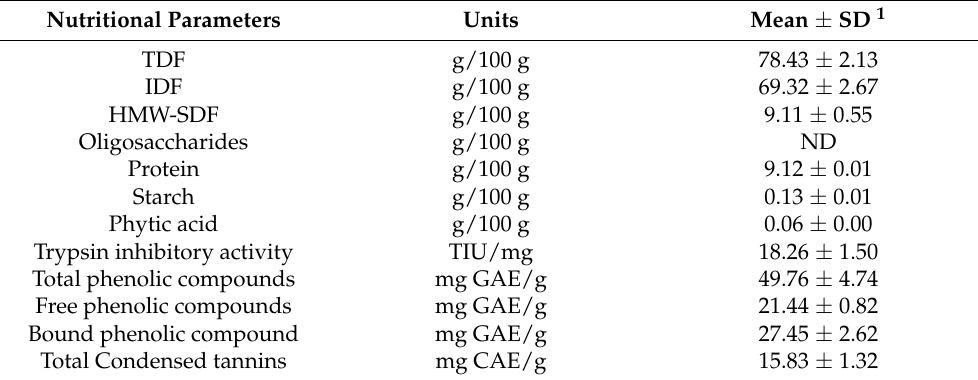
Table 1. Nutritional composition and total phenolic content of red lentil hulls from lentil processing industry (Prairie Pulse Inc., Vanscoy, SK, Canada). Nutritional Parameters Units Mean ± SD 1 TDF g/100 g 78.43 ± 2.13 IDF g/100 g 69.32 ± 2.67 HMW-SDF g/100 g 9.11 ± 0.55 Oligosaccharides g/100 g ND Protein g/100 g 9.12 ± 0.01 Starch g/100 g 0.13 ± 0.01 Phytic acid g/100 g 0.06 ± 0.00 Trypsin inhibitory activity TIU/mg 18.26 ± 1.50 Total phenolic compounds mg GAE/g 49.76 ± 4.74 Free phenolic compounds mg GAE/g 21.44 ± 0.82 Bound phenolic compound mg GAE/g 27.45 ± 2.62 Total Condensed tannins mg CAE/g 15.83 ±